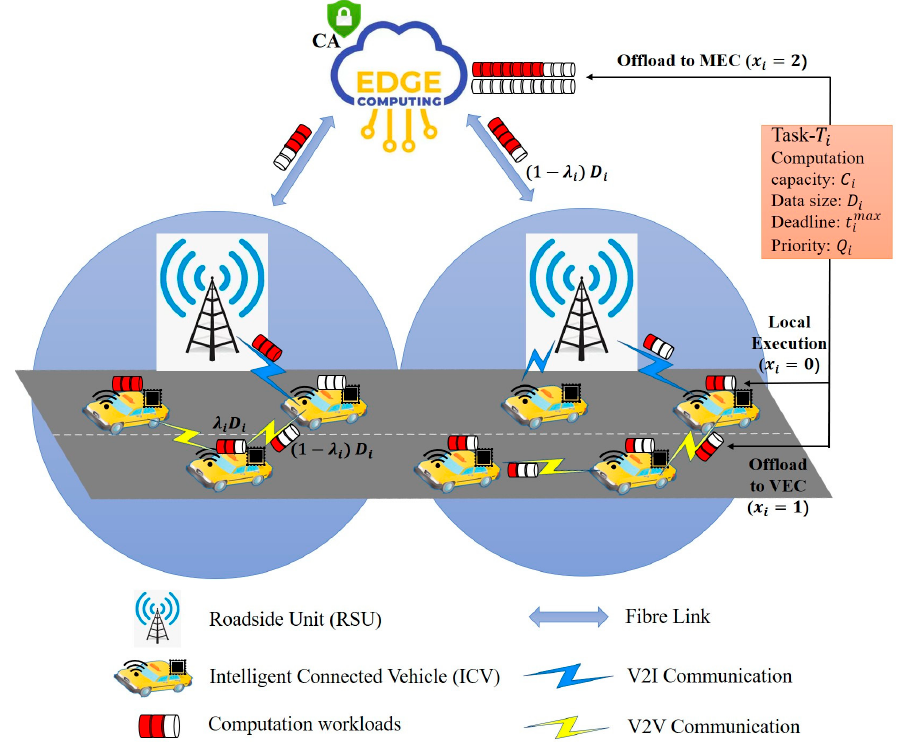
Figure 1. The system model of the VEN with privacy preservation.